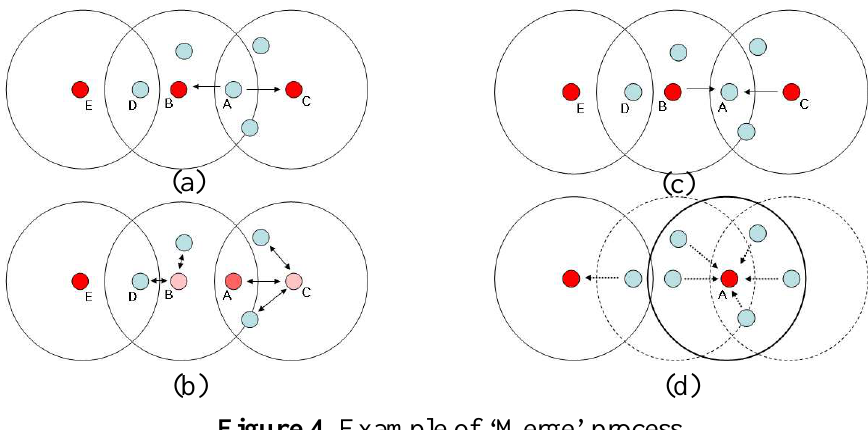
Figure 4. Example of ‘Merge’